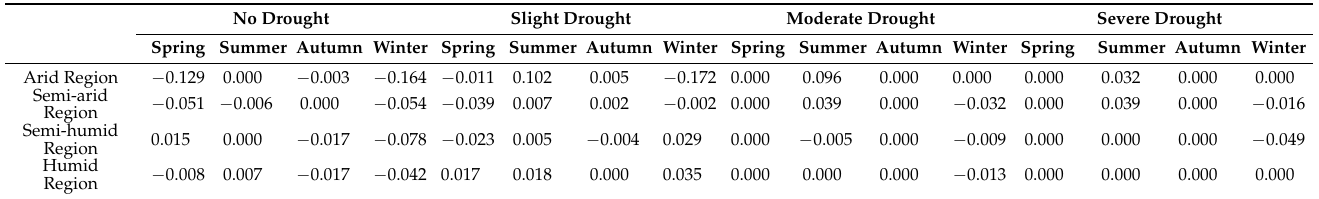
Table A2. Water-use efficiency (WUE) sensitivity coefficients in response to seasonal drought in climates